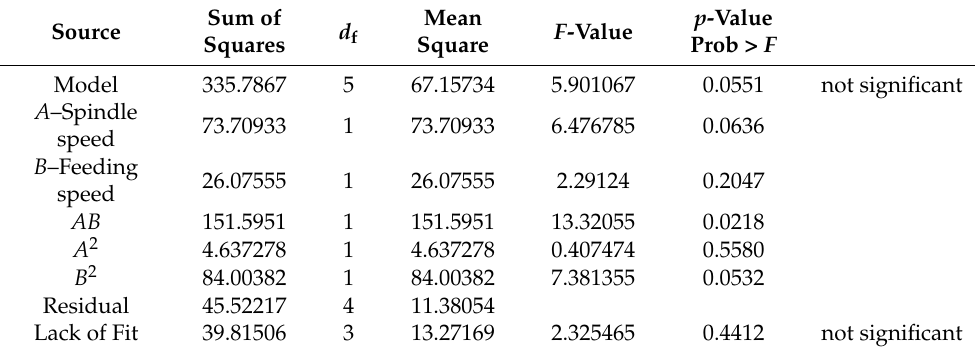
Table 6. Significance analysis of burr